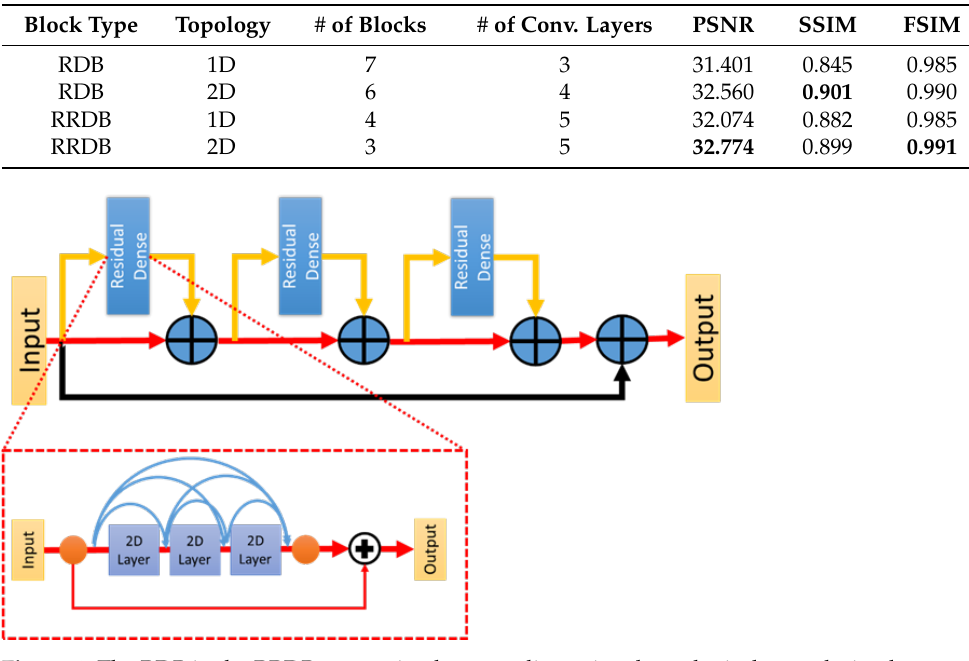
Figure 4. The RDB in the RRDB connection has two-dimensional topological convolution layers. Table 2. The best results of four combinations used to replace the original block in the EESN, where the best results are shown in boldface.